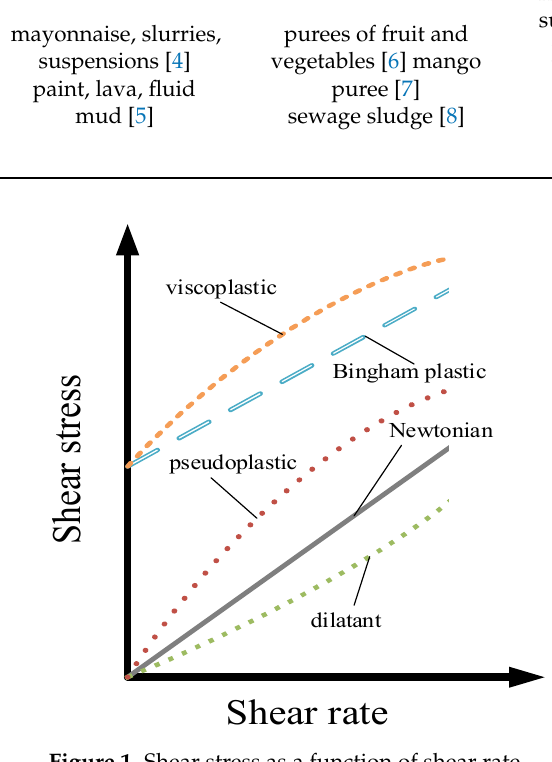
Figure 1. Shear stress as a function of shear rate. Table 1. Examples of each type of fluid.